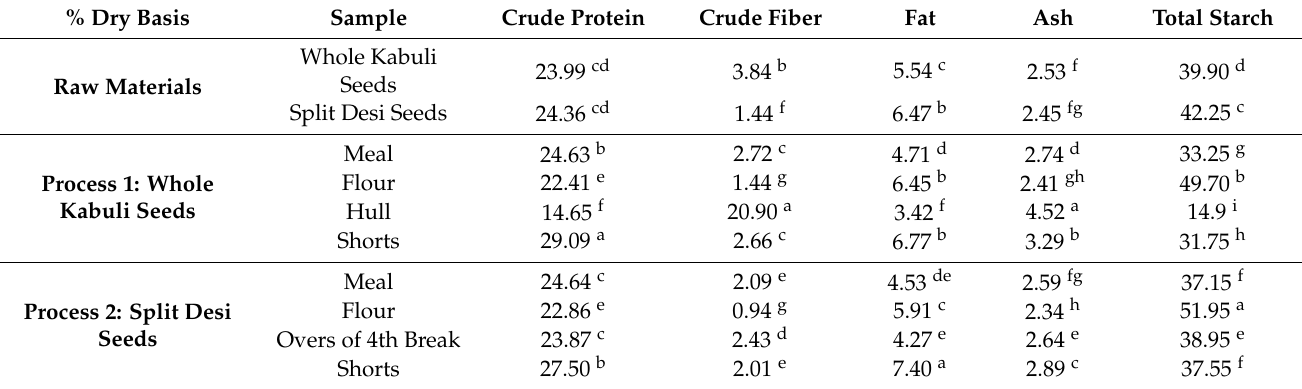
Table 4. Proximate Analysis of kabuli and desi